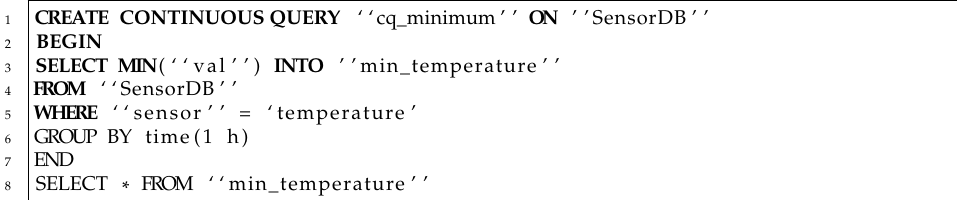
Figure 5. Continuous query in InfluxDB.